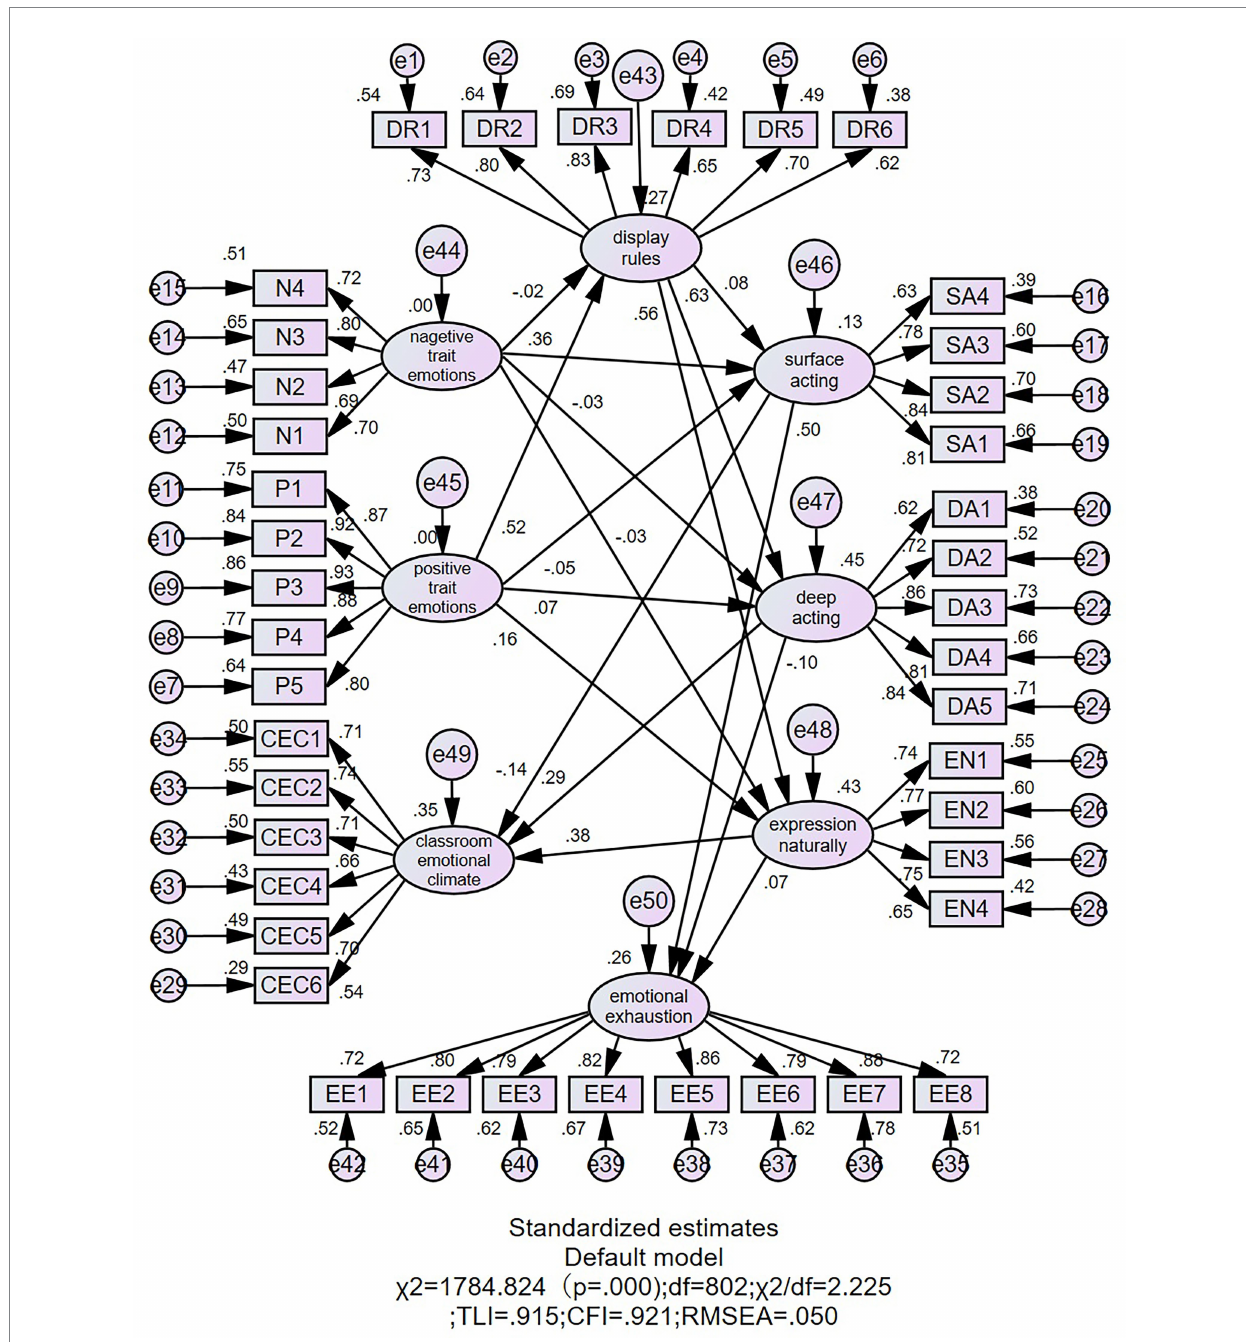
FIGURE 2 Structural equation model results ( N = 496). Expression naturally = expression of naturally felt emotions (Full name is too long to be validated in